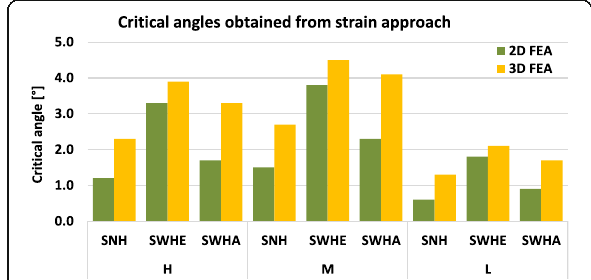
Fig. 21 Calculated critical angles of the specimens with failure criterion total strain ≤ A: The higher critical angles were obtained for specimens with drilled holes and the highest for the specimen SWHE